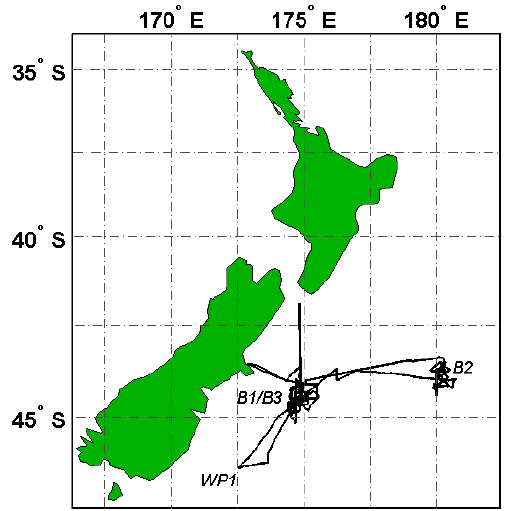
Figure 1. Cruise track during the SOAP study, which began and finished in Wellington, New Zealand. The phytoplankton blooms (B1–3) and waypoint 1 (WP1) locations are